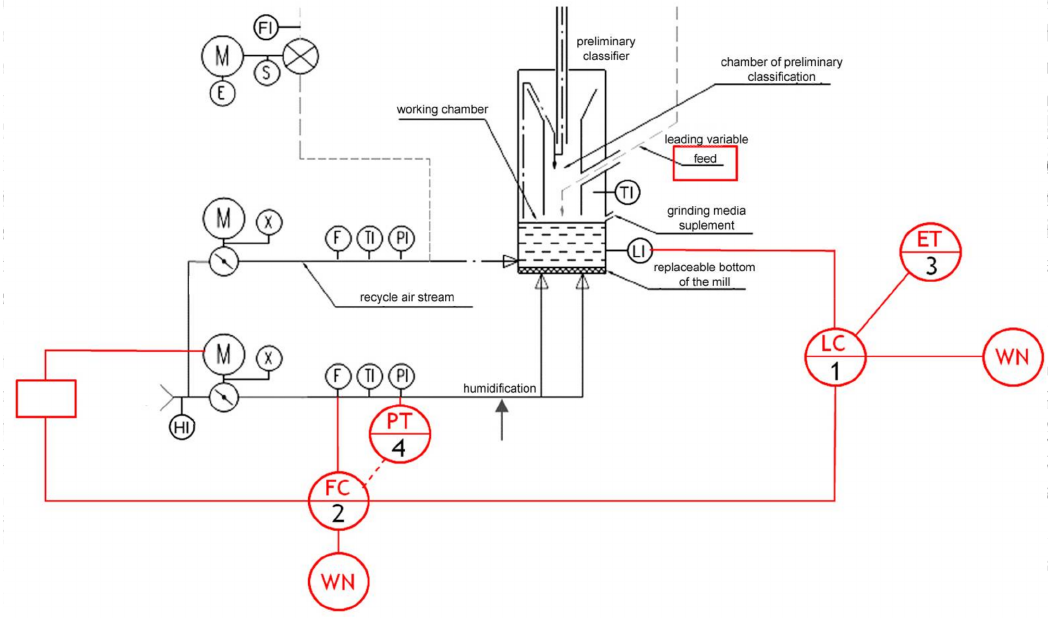
Figure 13. Functional structure of working chamber fulfilment control (measurement points are: F—flow, TI—temperature, PI—pressure, HI—humidity, X—position, LI—level, S—speed, E—voltage, FI—flow of the